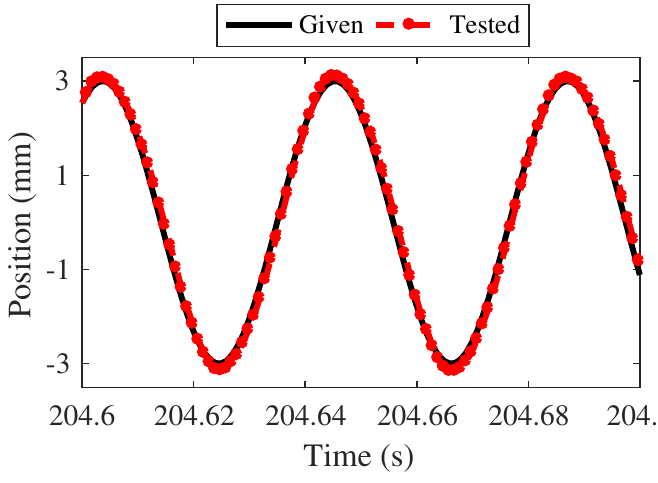
Figure 31. Position of